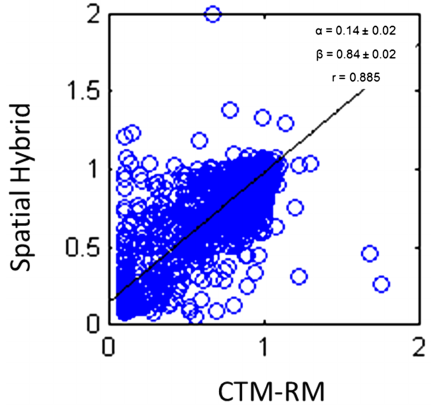
Figure 2. CTM–RM vs. spatial hybrid adjustment factors for withheld CSN observations. Regression statistics: intercept, α = 0.14 ± 0.02; slope, β = 0.84 ± 0.02; and correlation coeffi- cient, r = 0 . 89.